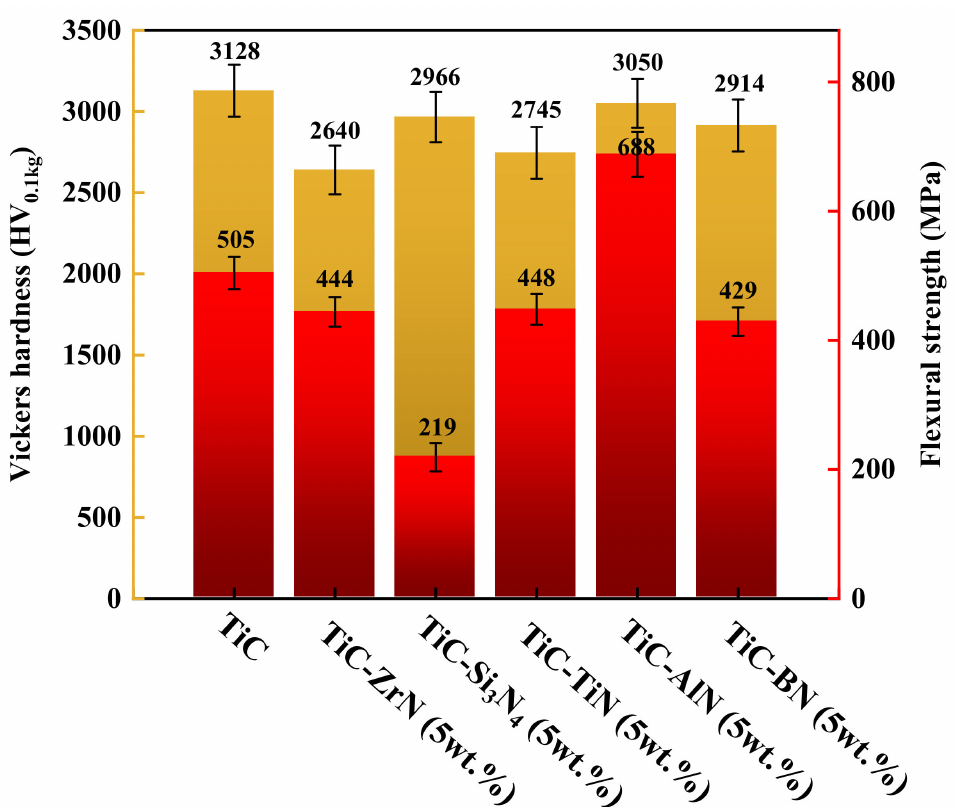
Figure 8. Mechanical properties of TiC-based ceramics with different nitride